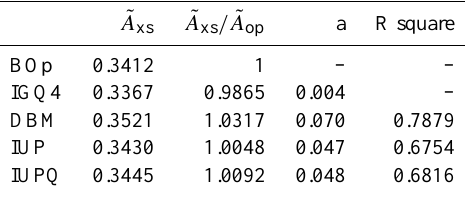
Table 6. Statistics of the linear relation of the differences based on Eqs. (16) and (17). The first column gives the differential cross- section A xs of the different cross section calculated for the nomi- nal Brewer (atmcm) − 1 , the second column shows the ratio of the differential cross section to the operative value for the nominal in- strument, and “a” is the slope of Eq. (17) in atmcmnm − 1 . The last column is the R-square coefficient of the linear fit (IGQ4 is flat).